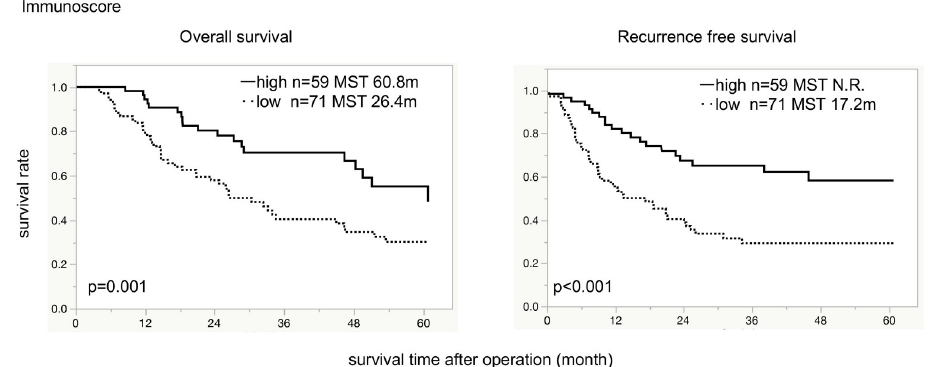
Fig 4. Overall survival and recurrence-free survival for tumor-infiltrating immune cells score. Immunoscore was assigned a number from 0 to 4, according to CD8+ high, CD4+ high, FOXP3+ high, and CD68+ low-infiltration. Kaplan-Meier survival curve indicates that the high Immunoscore group showed significantly superior OS and RFS than the low Immunoscore group. OS: overall survival, RFS: recurrence-free survival, MST: median survival time, N. R.: not reached.